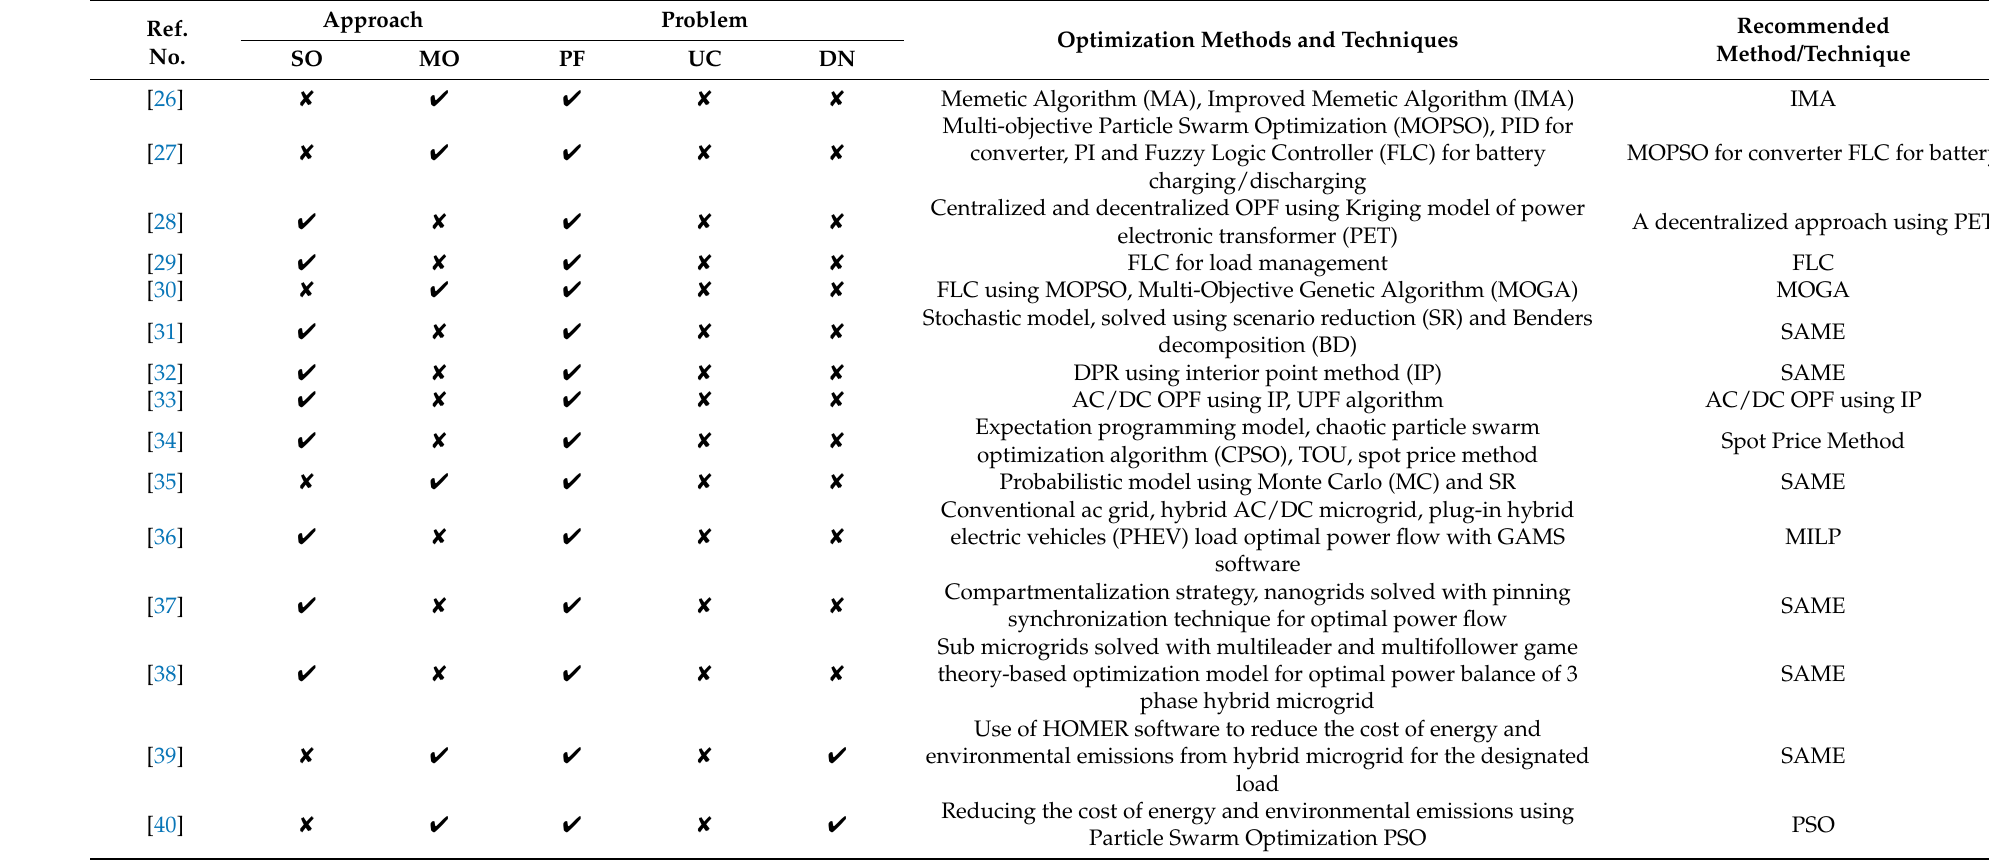
Table 1. Optimization approach; problem, methods, and techniques applied; and recommended method.